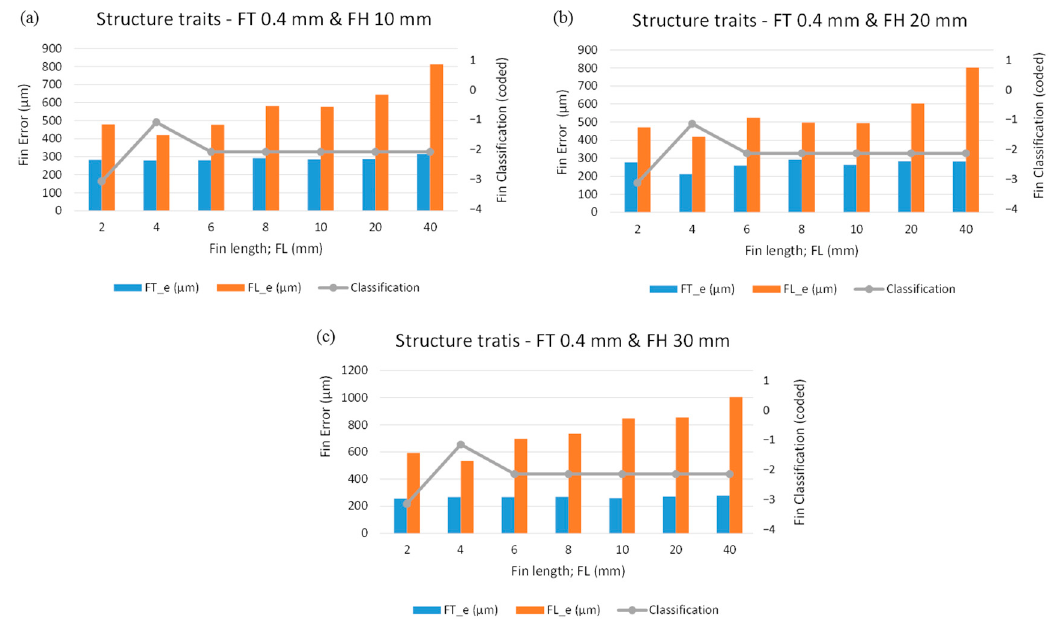
Figure 7. Graphical analysis of structure traits under the second phase of experimentation with designed fin thickness (FT_d) of 0.4 mm: ( a ) FH 10 mm, ( b ) FH 20 mm, and ( c ) FH 30 mm.